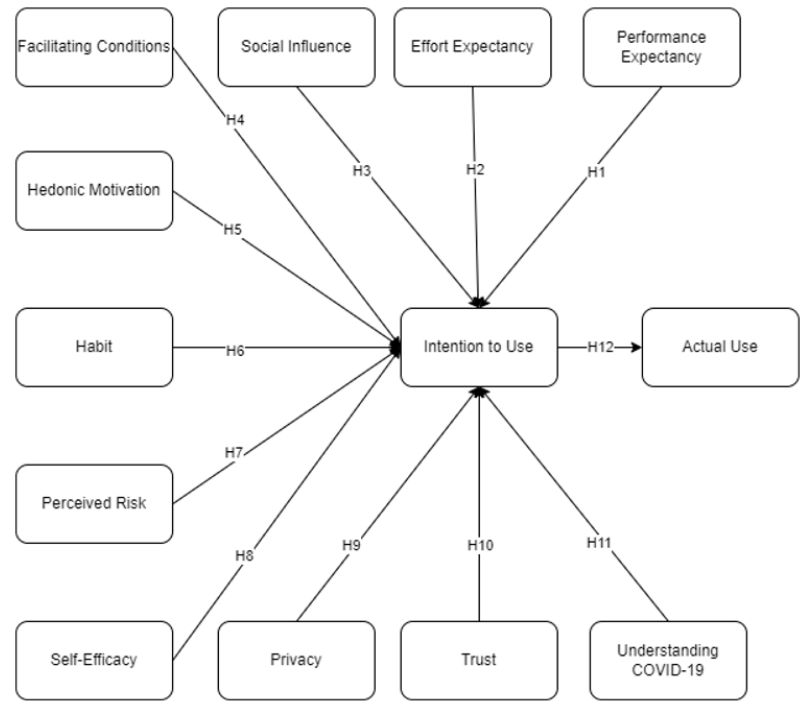
Figure 2. Conceptual framework.